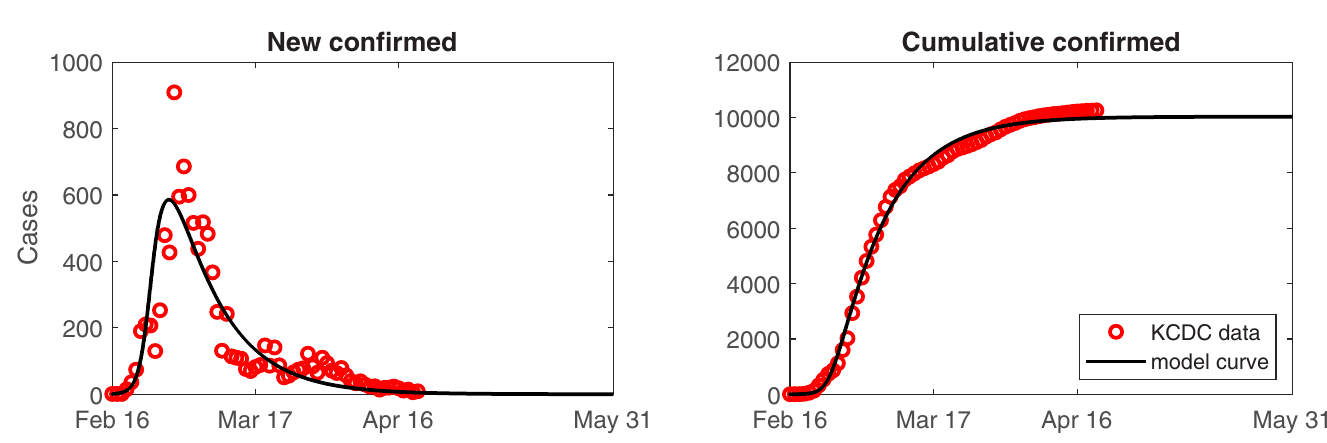
Fig 3. Predicted number of cases from the model until mid-May. Daily (left) and cumulative (right) number of confirmed cases.